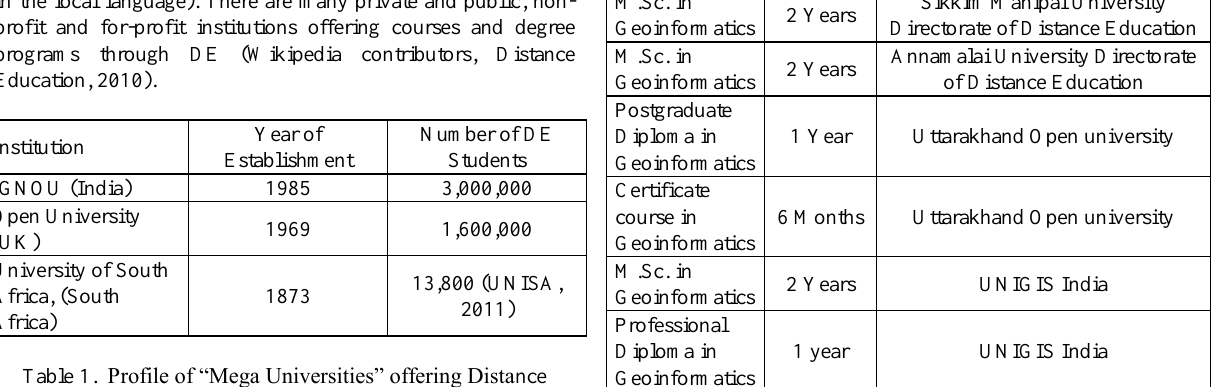
Table 1. Profile of ―Mega Universities‖ offering Distance Education. Adapted from (Jung, 2005) & updated June 2011